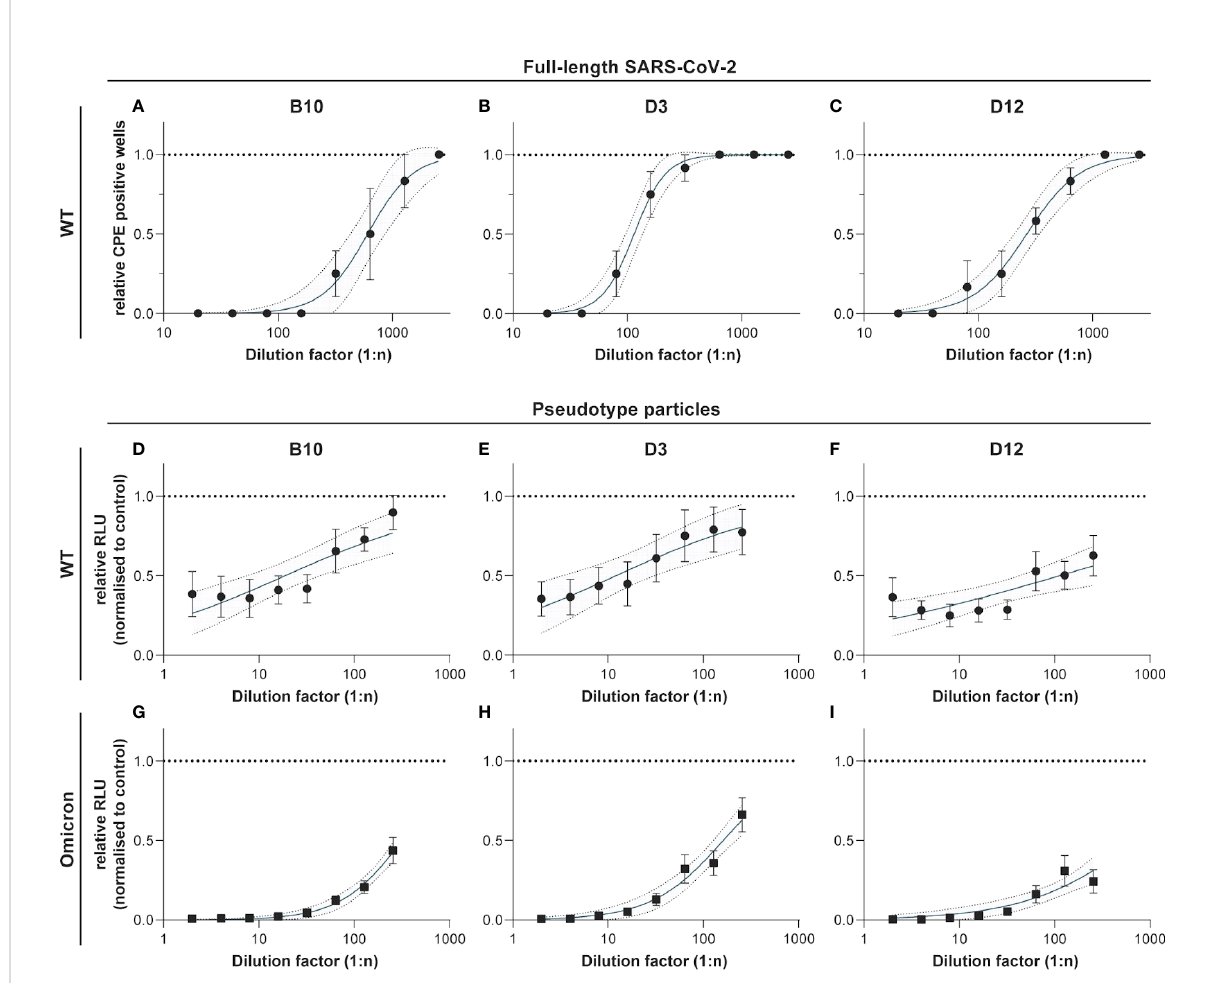
FIGURE 6 Neutralization experiments with SARS-CoV-2 wildtype virus and pseudotyped viruses (wildtype and Omicron). HcAbs B10, D3 and D12 were used for neutralization experiments with the wildtype virus hCoV-19/Germany/BY-Bochum-1/2020 (B.1.1.70) (A – C) and with a propagation- incompetent VSV* D G pseudovirus system for the wildtype (D – F) and Omicron (G – I) . VSV* D G were incubated with a two-fold dilution of hcAbs and used for infection of VeroE6 cells. Neutralization was measured using a Fire fl y luciferase (FLuc) reporter system. The reciprocal antibody dilution causing 50% inhibition of the luciferase reporter was calculated (ND50) in 3 independent experiments. Mean and standard deviation are shown as well as a 95% con fi dence interval set off with